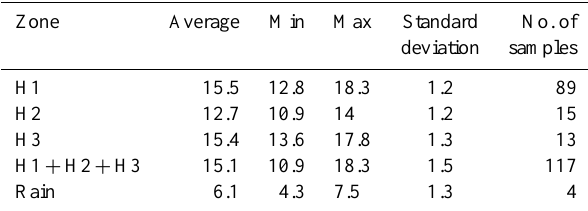
Table 2. Results of EC measurements (µScm − 1 ) in the forefield. The zones refer to those drawn in Figs. 1 and 6.